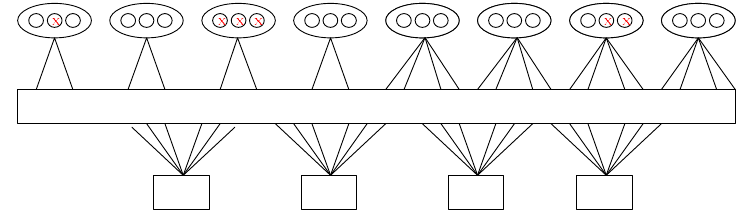
Figure 2. The bit-level puncturing pattern of the NB-LDPC